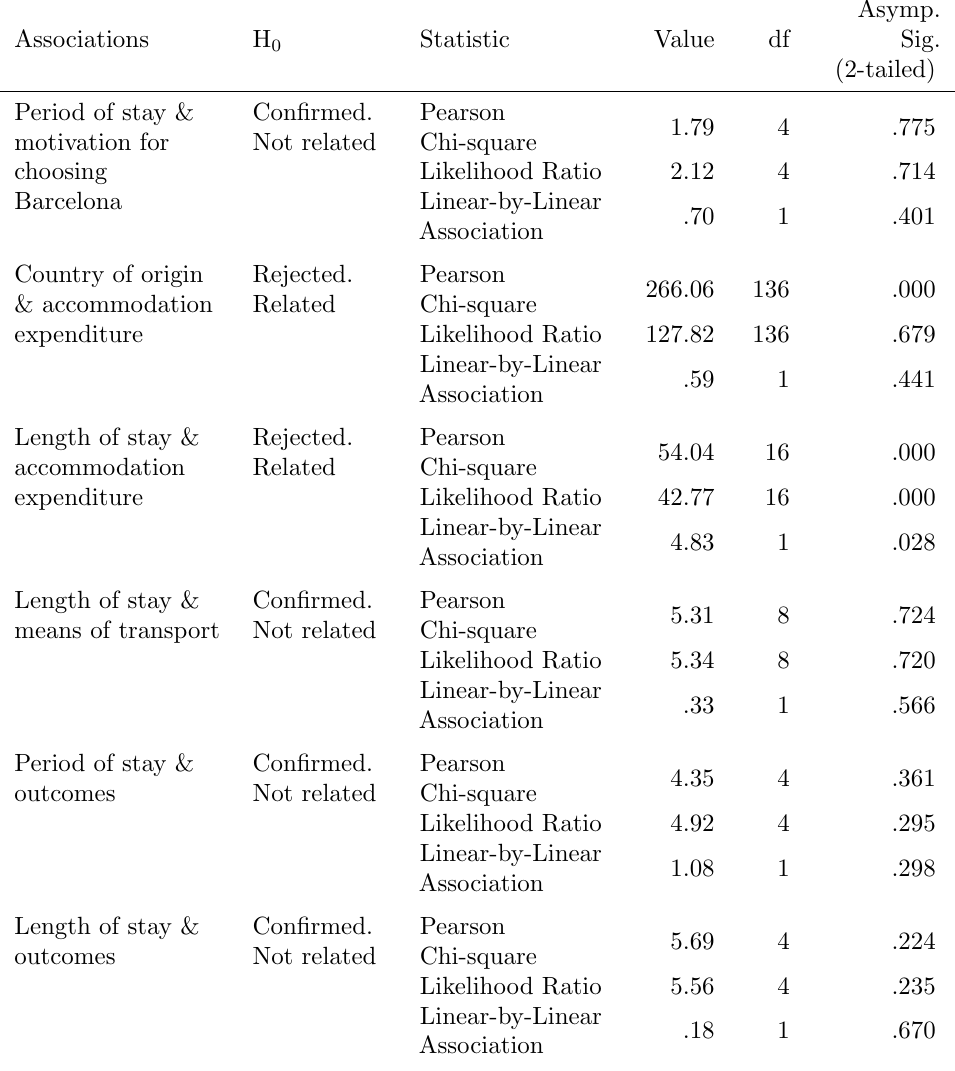
Table 4: Chi-square test